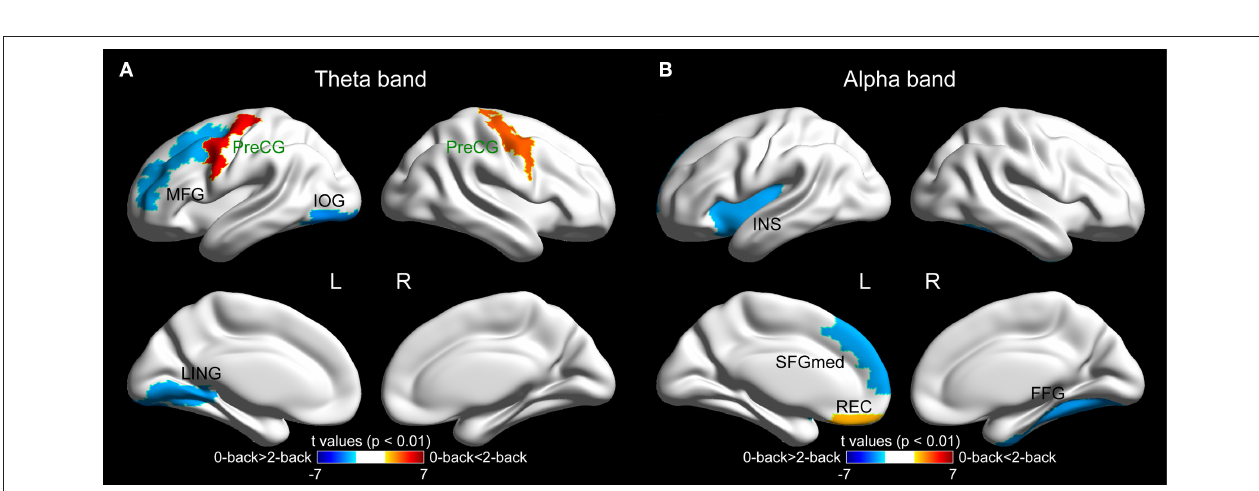
FIGURE 5 | The surface spatial distribution of the cortical regions showing significantly different betweenness centrality values between the 0-back and 2-back tasks ( p < 0.01) in (A) theta band and (B) alpha band. The color bar represents the t -values of the corresponding regions obtained from paired t- test between the two tasks. The names of the regions that survived the FDR correction are highlighted in green. The brain regions were overlaid on inflated surface maps with the BrainNet Viewer toolbox (Xia et al., 2013). For the abbreviation of the cortical regions, see Table S1. L = left, R =